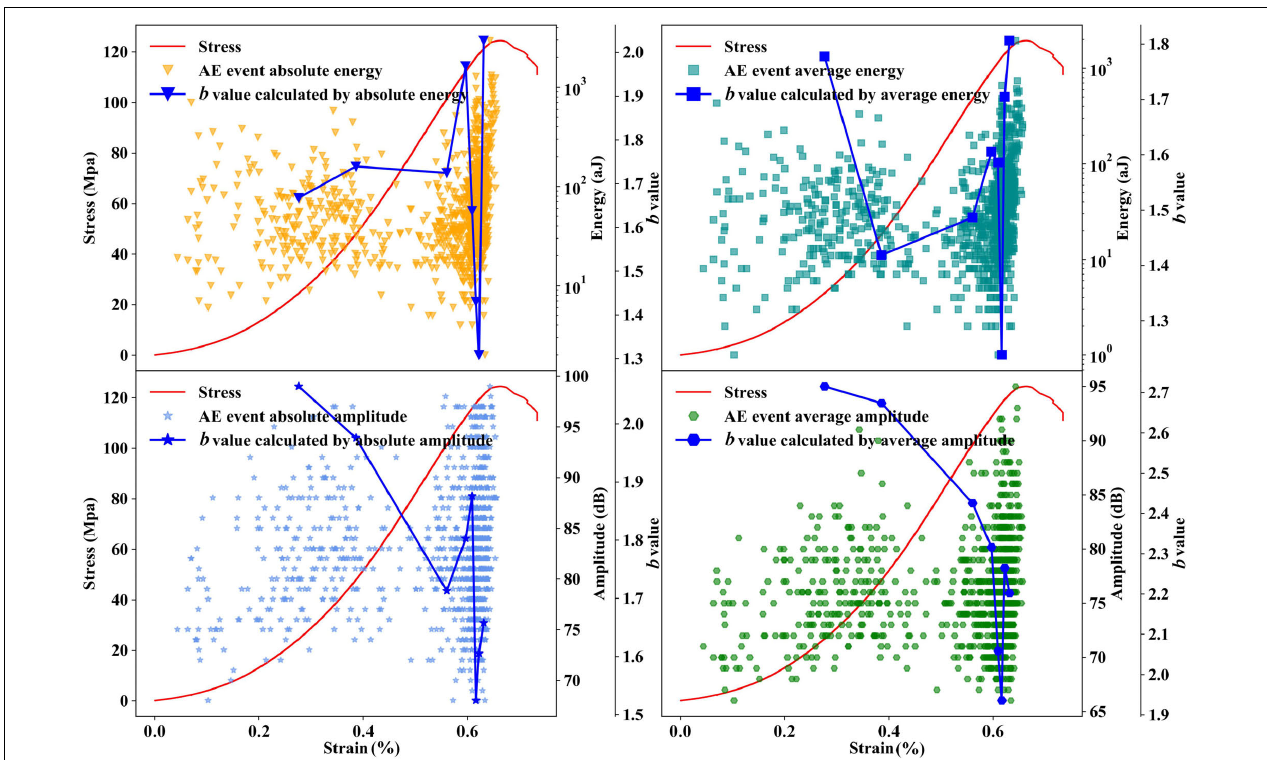
FIGURE 4 | The variation in 4 AE b values (blue point-line) of saturated water granite versus strain under uniaxial compression. The distribution characteristics of the absolute amplitude (blue point), absolute energy (orange point), average amplitude (cyan point), and average energy (green point) of the AE event show good consistency with the fluctuation of the b